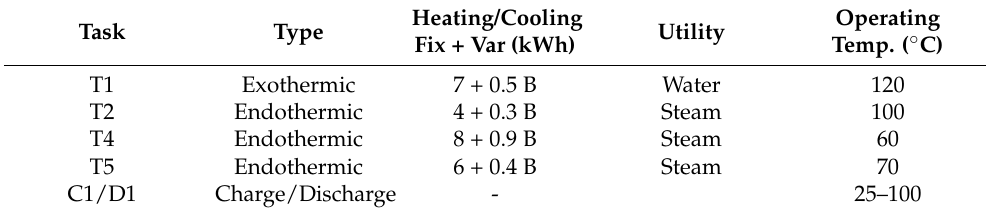
Table 3. Energy requirements and characteristics of Example